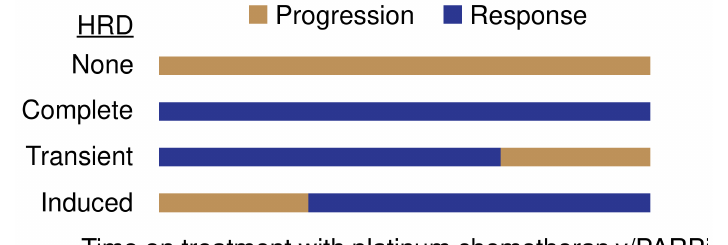
Figure 1. Clinical scenarios of homologous recombination deficiency (HRD). PARPi, poly (ADP- ribose) polymerase